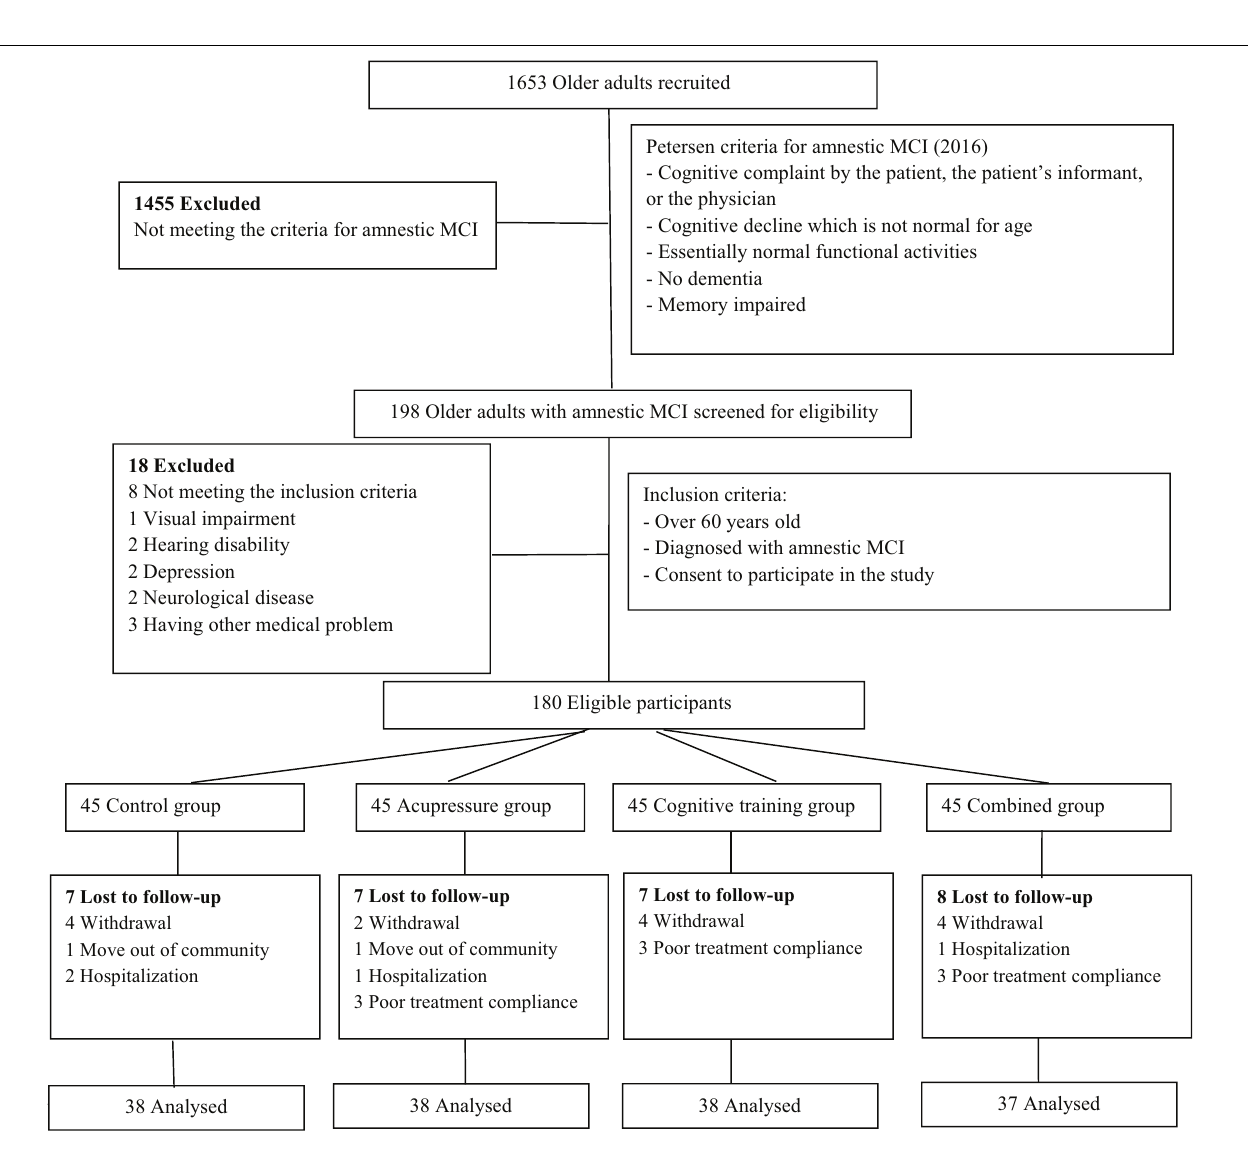
of the baseline scores of MMSE and MoCA among groups ( p >